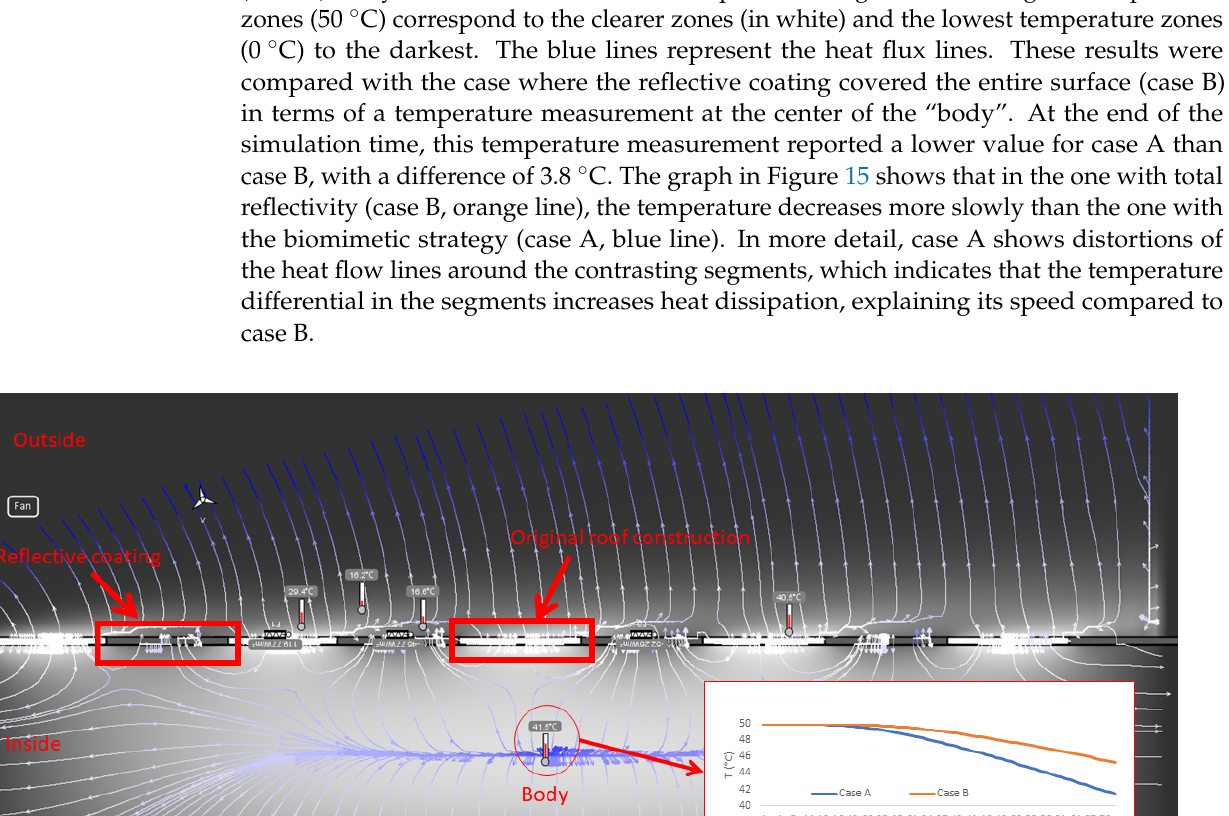
Figure 14. Comparison of monthly electricity consumption for cooling (only for occupied hours). Own elaboration.